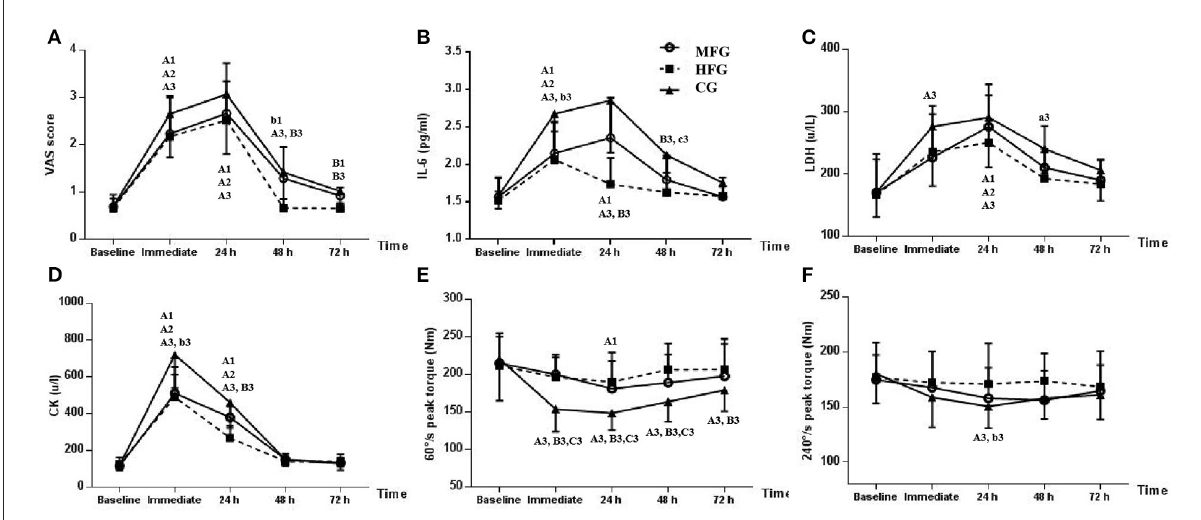
FIGURE1 Changs in the three groups at different time points. MFG, medium-frequency group; HFG, high-frequency group; CG, control group. Values at different time points were compared with the baseline in the same group: a1 (MFG), a2 (HFG), and a3 (CG) indicate P < 0.05; A1 (MFG), A2 (HFG), and A3 (CG) indicate P < 0.01. MFG or CG was compared with HFG at the same point in time: b1 (MFG) and b3 (CG) indicate P < 0.05. B1 (MFG) and B3 (CG) indicate P < 0.01. CG was compared with MFG at the same point in time. c3 (CG) indicates P < 0.05. (A) VAS score. (B) IL-6. (C) LDH. (D) CK. (E) 60 ◦ /s peak torque. (F) 240 ◦ /s peak